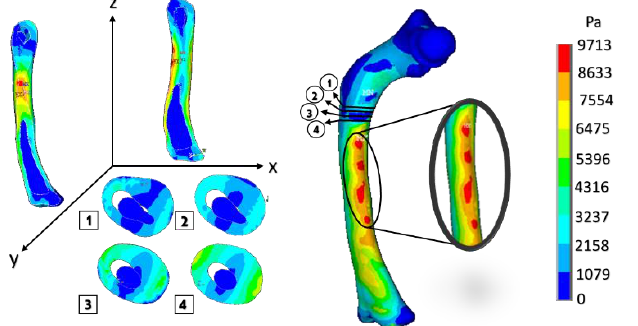
Figure 20. Isotropic analysis of the comminuted fracture case. Von Mises stress showing maximum stress of 9.713